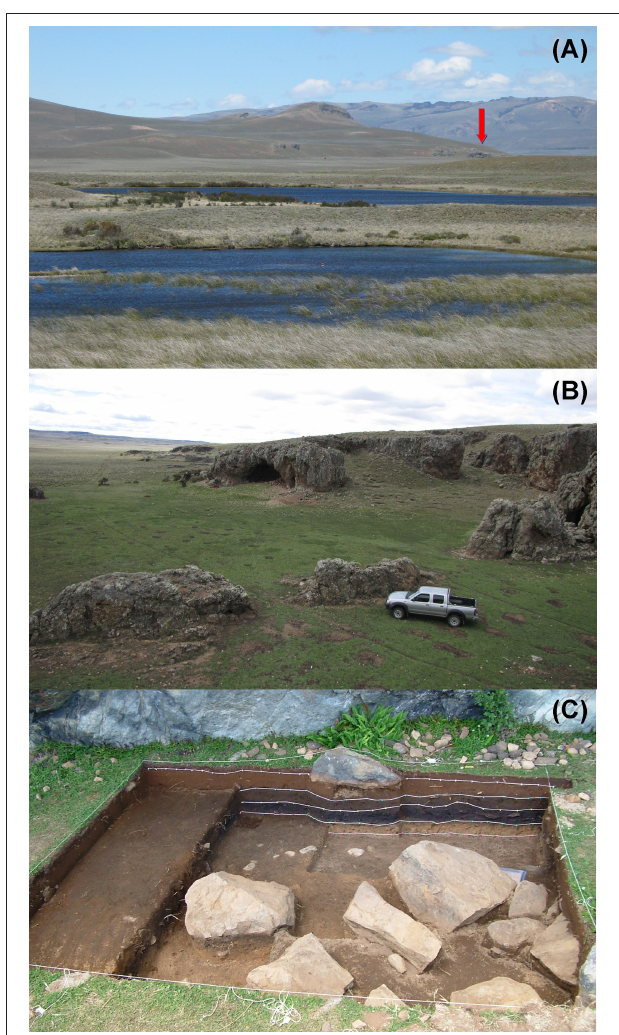
FIGURE 4 | (A) View from Lake Shaman coring site to El Chueco 1 archeological site (red arrow), (B) El Chueco 1 cave site, and (C) excavations at Las Quemas rockshelter showing the distinctive charcoal full stratigraphic unit 4 (black stratum).